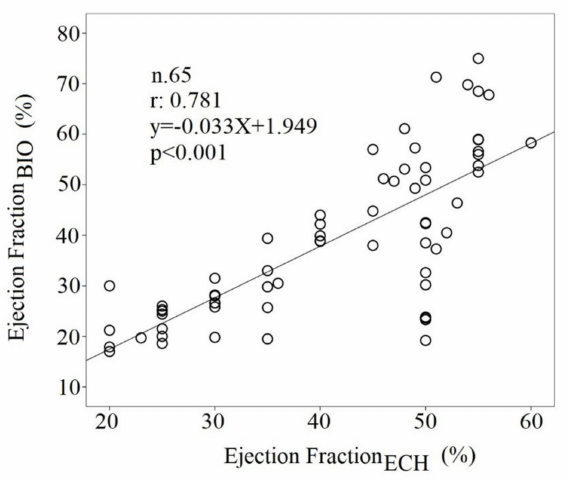
Figure 6. Regression analysis between LVEFECH and